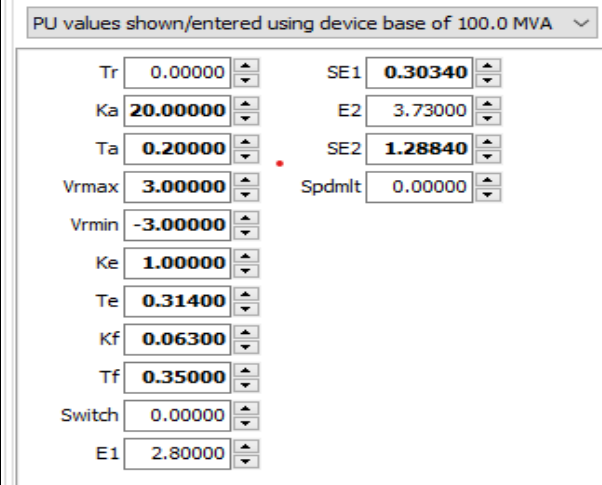
6 of 19 Table 3. Parameter of Generator Impedance and Time Contact. Generator 1 and 2 Parameters